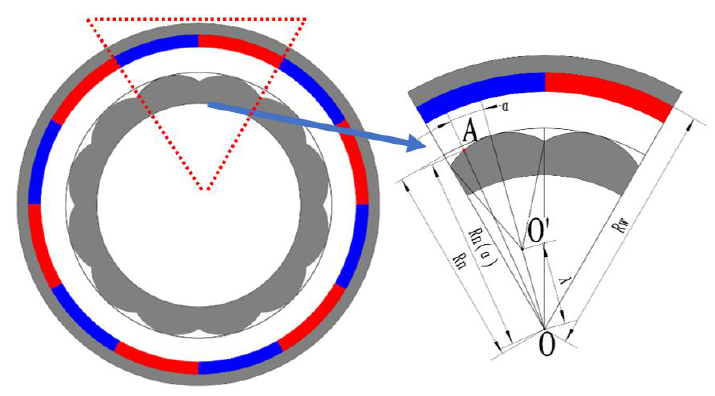
Figure 3. Structural diagram of the eccentric design of the inner rotor.